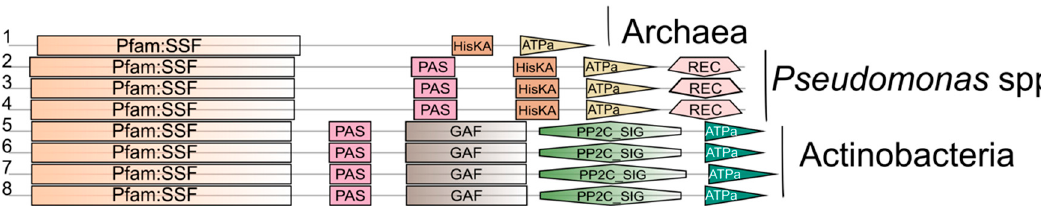
Figure 6. Gram-positive organisms containing SSS family domain associated to HATPase_c. SMART database was used to identify proteins containing Pfam:ssf and HATPase_c (presented in the figure as “ATPa”) domains. Four isolates of Actinobacteria (5: Actinospica acidiphila , 6: Streptomyces griseorubens , 7: Streptomyces albus , 8: Streptomyces gilvosporeus ) were selected and, as a comparison, three Pseudomonas spp. (2: Pseudomonas stutzeri , 3: Pseudomonas fluorescens Q2-87, 4: Pseudomonas corrugata ) and one Archaea were also analyzed (1: Candidatus Nitrosocaldus cavascurensis). The ID of the isolates (SMART database) can be found in Table S2.